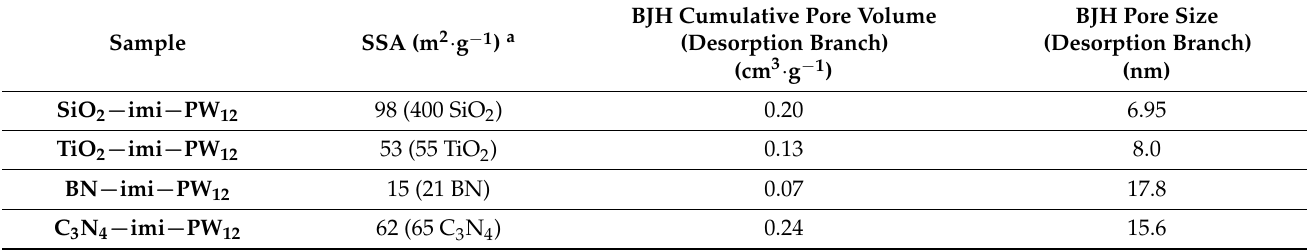
Table 1. Specific Surface Area (SSA), cumulative pore volume and pore size of the functionalized materials.